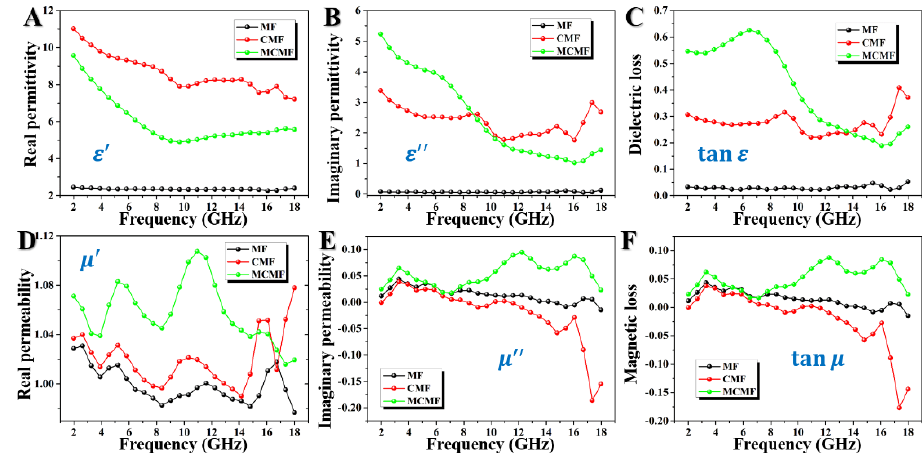
Figure 5. Dielectric ( A – C ) and magnetic ( D – F ) parameters of MF, CMF and MCMF, respectively.